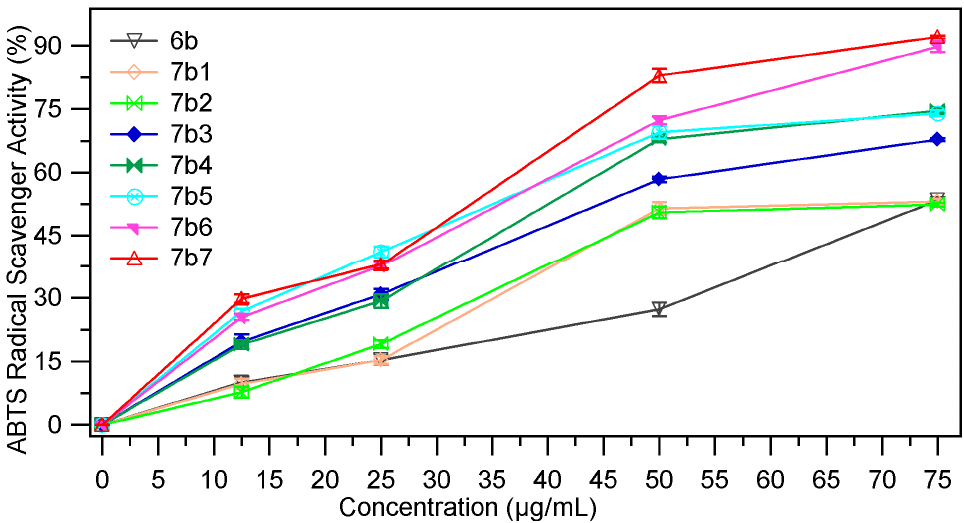
in ref. with 6b 1–7